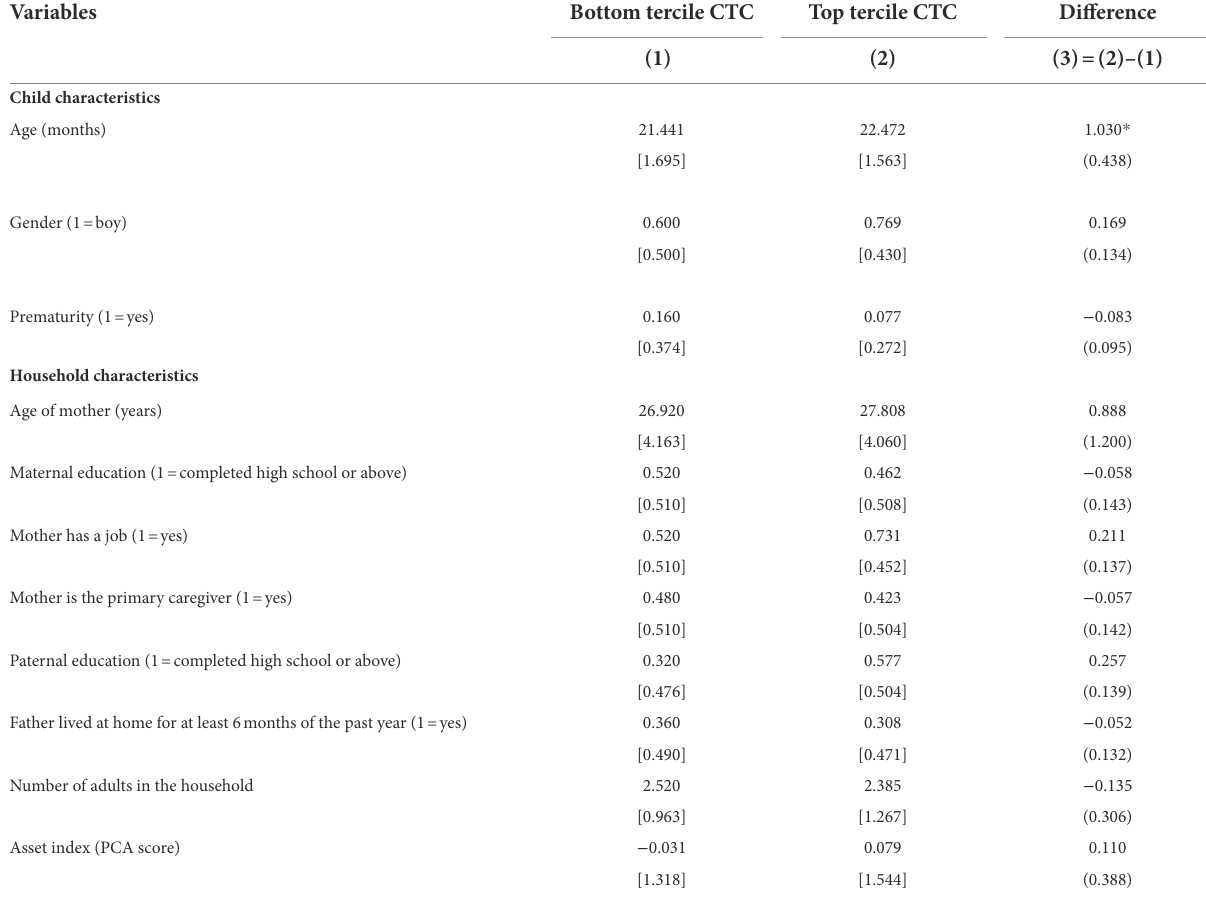
TABLE 3 Differences in demographic characteristics between top and bottom terciles of Conversational Turn Count